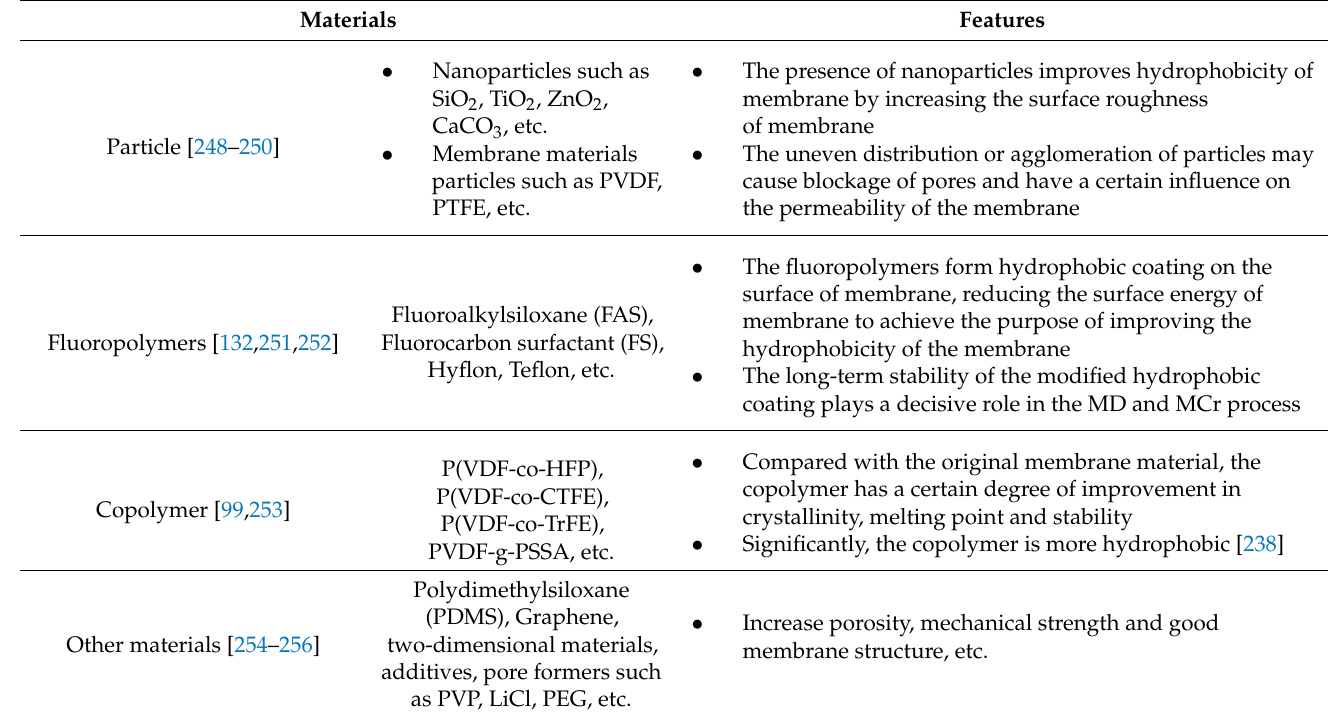
Table 6. Materials for modification of fluoropolymeric membrane for